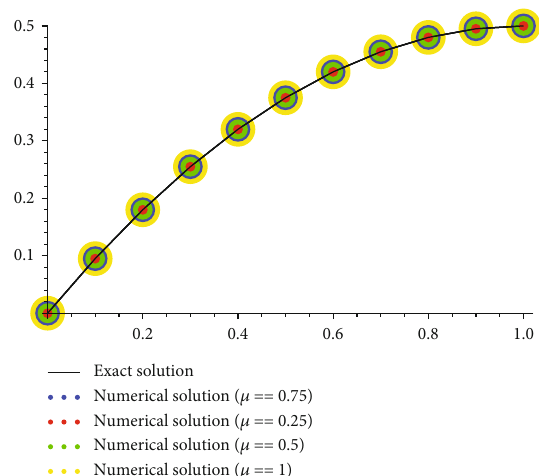
Figure 29: Absolute errors of u 2 obtained by the present 1 obtained by the present method for Example